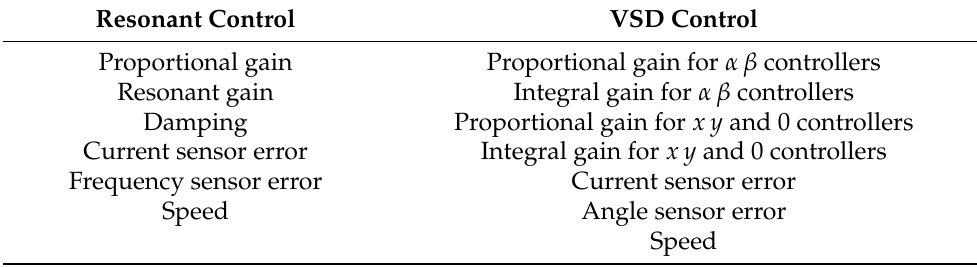
Table 2. Studied operating